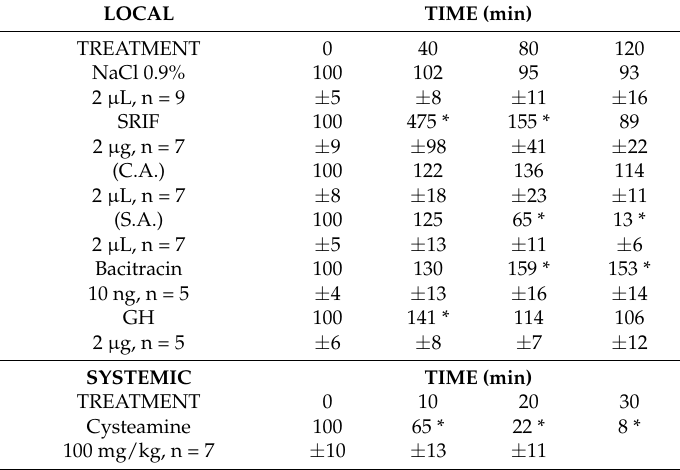
Figure 2. Typical DPVoltammograms monitored in the striatum of anesthetized rats following local injection of SRIF (top, n = 1), SRIF antisera (S.A.), i.e., antibodies for SRIF (rabbit polyclonal, IgG antiSRIF AB5494); Millipore (MERCK) (middle, n = 1); or control antisera (C.A.), i.e., non specific antibodies in the striatum of a single animal (bottom, n = 1). See Table 2 for data obtained in groups of rats treated as above (n = 7 each treatment), as well as with NaCl 0.9% (control group, n = 9), Bacitracin (n = 5), GH (n = 5) and Cysteamine (n = 5). Table 2. In vivo effect of various treatments on DPV-µCFE striatal Peak 5 of anaesthetized rats. Data are presented as % of control (pretreatment) values, mean ± SD, * p < 0.05, Tukey test. LOCAL TIME (min) TREATMENT